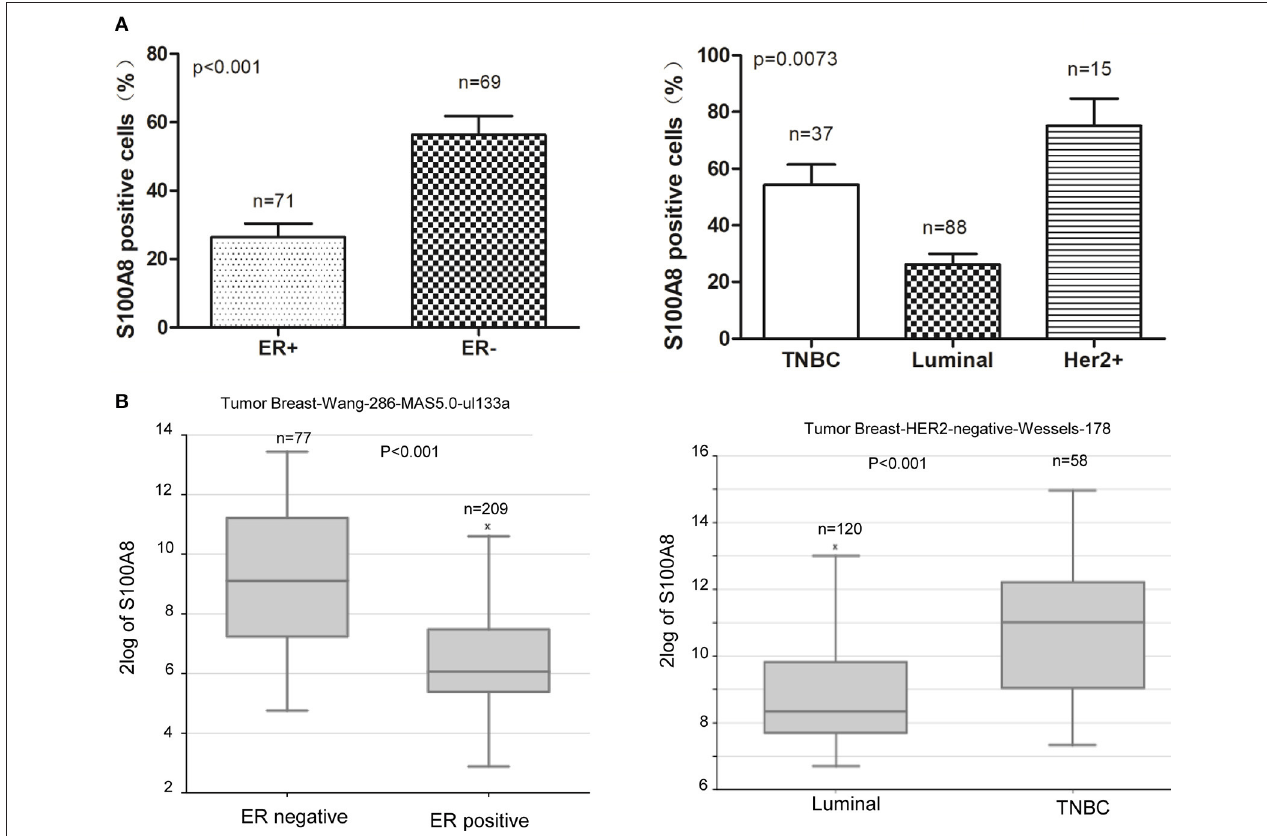
FIGURE 4 | S100A8 is overexpressed in ER-negative breast cancer tissue. (A) The percentages of S100A8-positive cells in different ER status breast cancer tissue samples (left) and triple-negative (TNBC) and luminal breast cancer tissue samples (right). (B) S100A8 gene expression in breast cancer patients with different subtypes of breast cancer was plotted using the R2 online database.